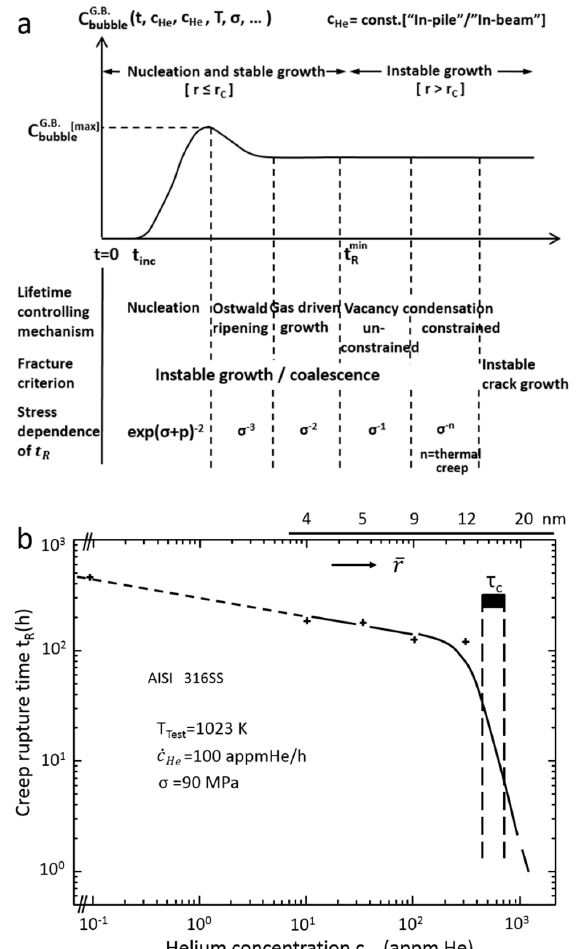
Figure 21. ( a ) The bubble evolution process along GB in creep test [158]; and ( b ) the creep rupture time decreases with increasing He concentration. The creep rupture time decreases sharply when He bubble size reaches the critical size [18]. Reprinted with permission from [158]; Copyright 1983 Informa UK Limited; Reprinted with permission from [18]; Copyright 1985 Elsevier.